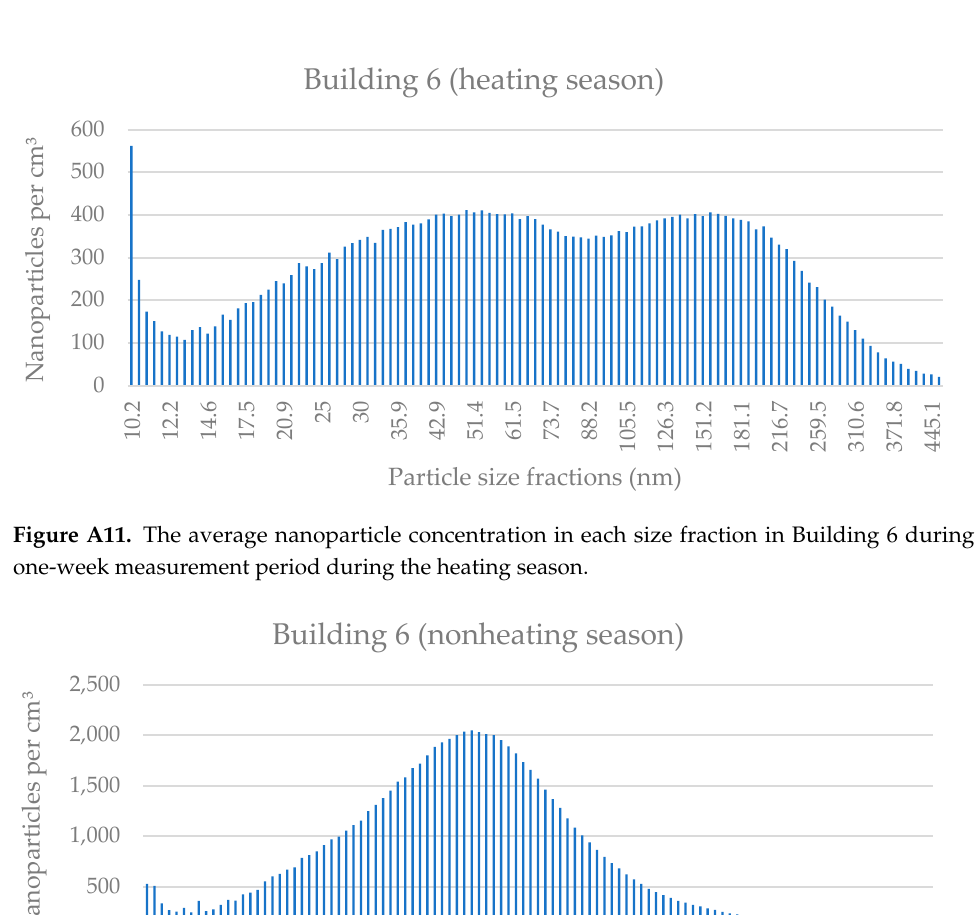
Figure A10. The average nanoparticle concentration in each size fraction in Building 5 during a one- week measurement period during the nonheating season.